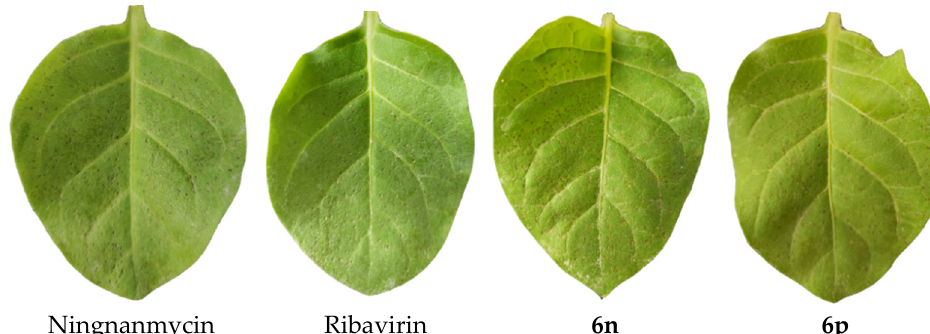
Figure 2. Inactivation activities of the compounds against TMV at 500 μ g/mL.